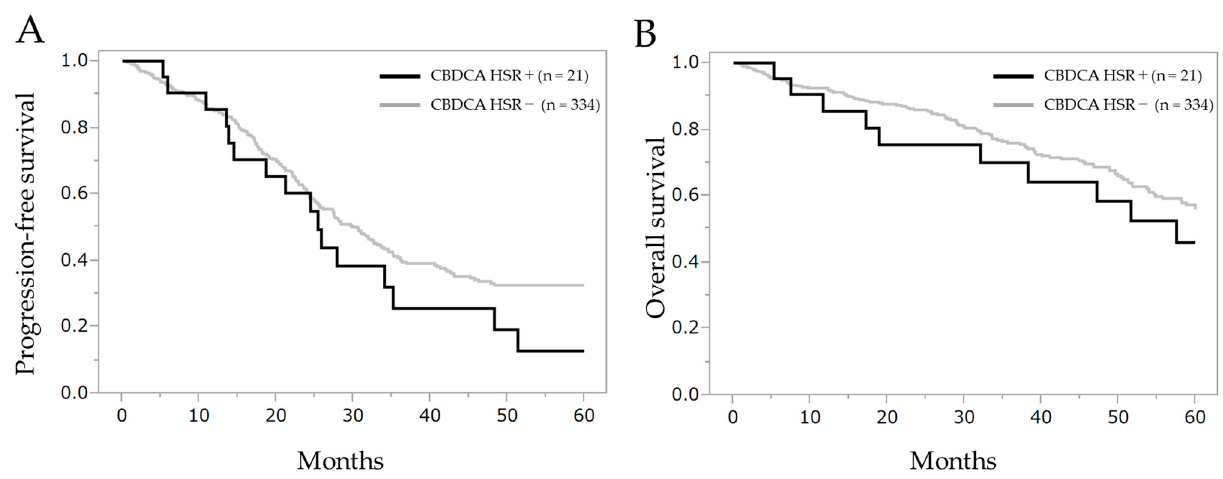
Figure A1. Comparison of progression-free survival and overall survival between patients with carboplatin hypersensitivity reaction or not. ( A ) Progression-free survival and ( B ) overall survival after the initial treatment. CBDCA HSR: carboplatin hypersensitivity reaction.